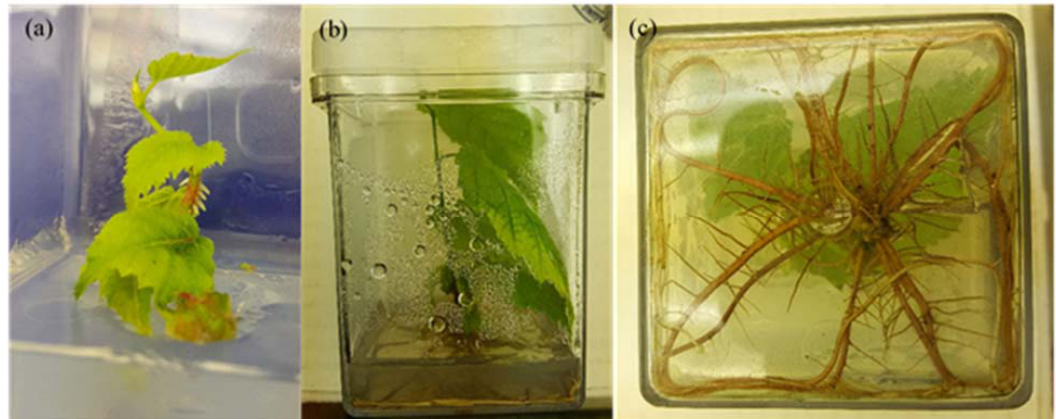
Figure 1. ( a ) Hazelnut (genotype Humble16) shoot with visible roots 12 days after transition for 24-h light at the IBA dark/light treatment; ( b ) shoot 30 days after transfer to 24-h light at the IBA dark/light treatment; ( c ) roots at 30 days viewed from the bottom of the culture vessel.